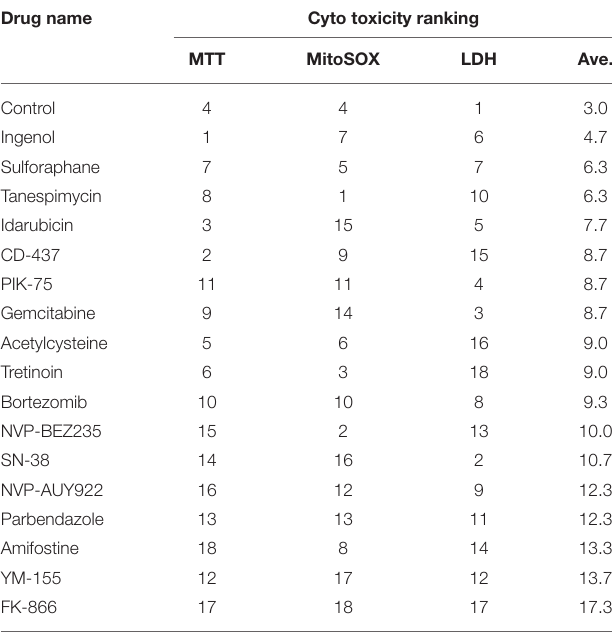
TABLE 2 | Consensus ranking comprising of MTT, MitoSOX, and LDH cytotoxicity